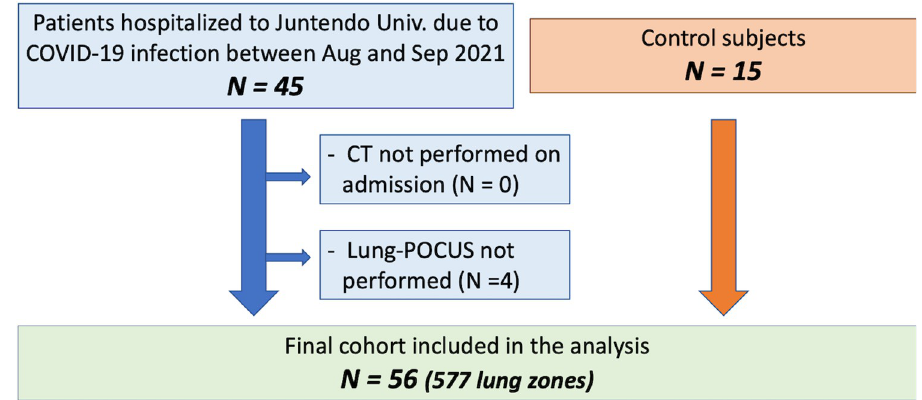
Fig 3. Patient inclusion chart. Only 4 patients (8.9%) of cases were excluded and 56 patients (41 cases and 15 controls) were included in the final analysis.